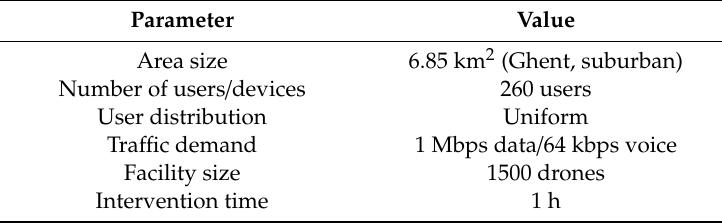
Table 1. Scenario simulation parameters .